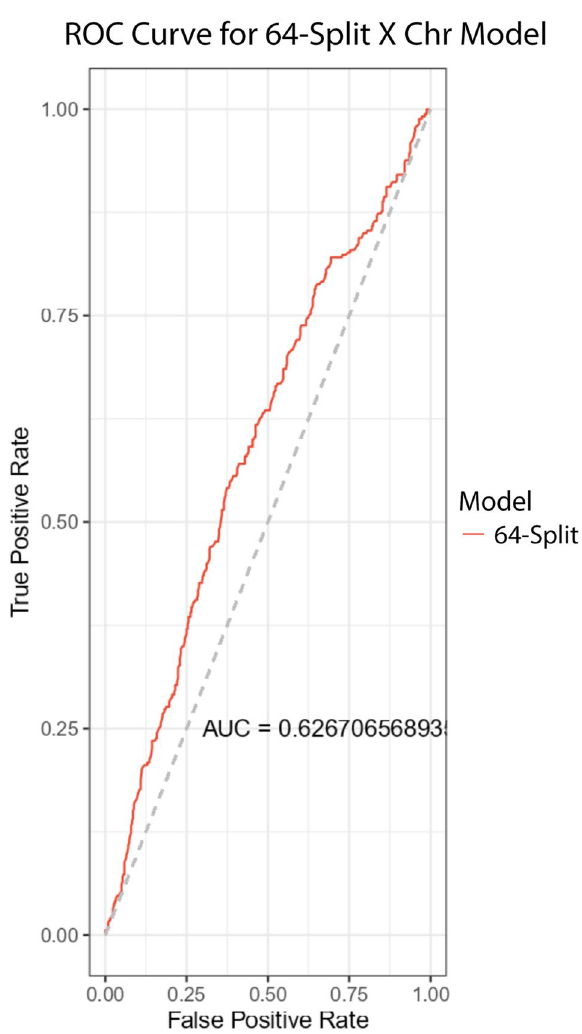
Figure 6. This ROC Curve for a schizophrenia prediction model utilizing 64-splits or 64 CSLVs of chromosome X only. The reported AUC is